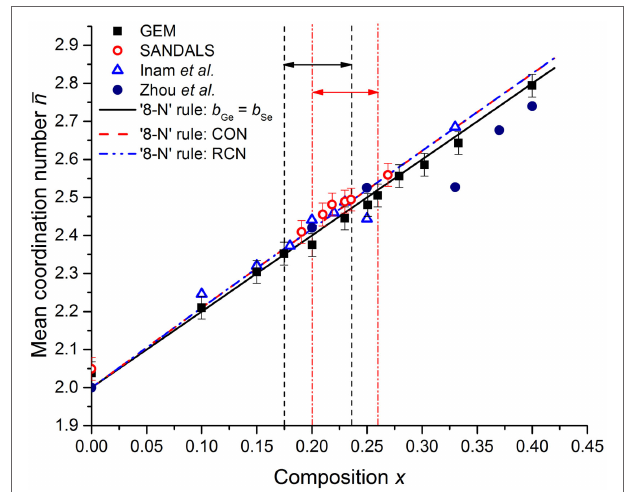
FIGURE 10 | The composition dependence of the mean coordination number ¯ n for the Ge x Se 1 (cid:0) x system. The neutron diffraction results from GEM and SANDALS are compared to the EXAFS results of Zhou et al. (1991) and to the first-principles molecular dynamics results of Inam et al. (2007). The expectations of the “8-N” rule are also given, where the curves were calculated (i) for glassy samples for which b Ge = b Se (see equation (5)), or (ii) for the expectations of the CON and RCN models, taking into account a small mismatch between the values of b Ge and b Se for the measured samples (see equation (3)). The pairs of vertical dashed (black) or chained (red) lines, and associated horizonal arrows, mark compositions for which ∆ H nr ≃ 0 as found in the present work or in the work of Boolchand et al. (2001a), respectively.